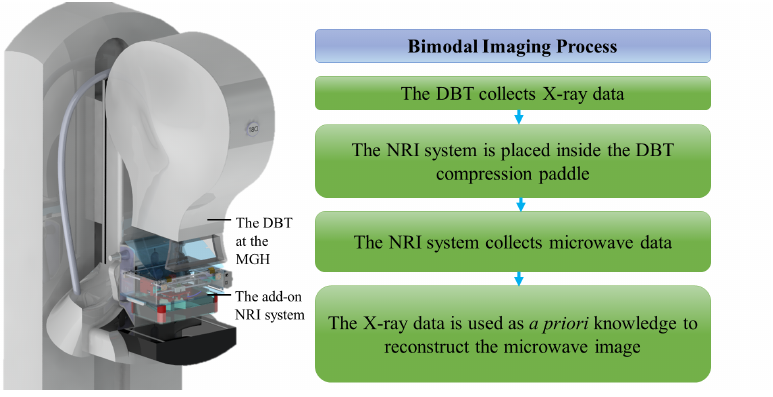
Figure 2. The bimodal imaging process using the DBT and